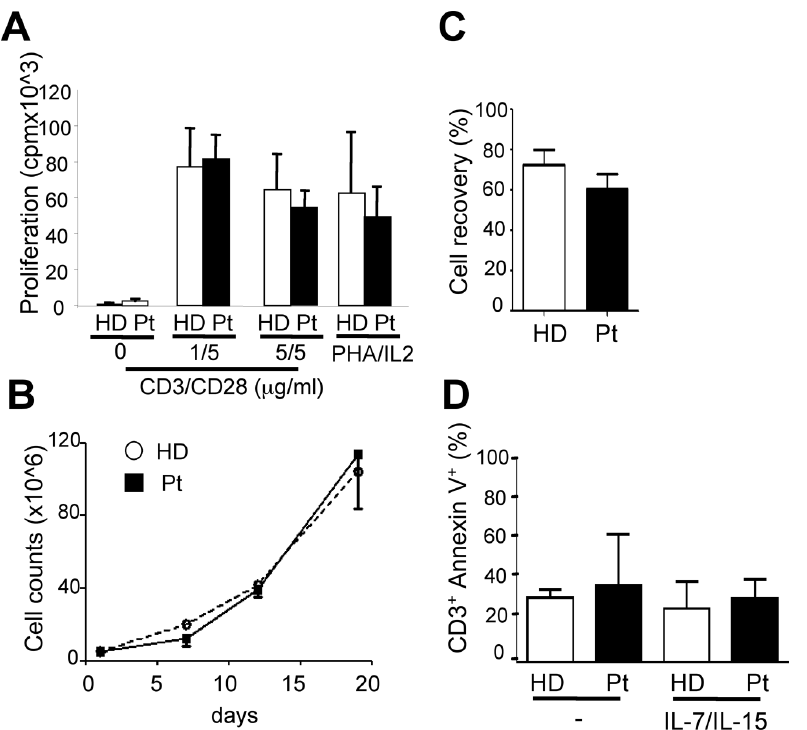
Figure 3. T cells from TSC subjects proliferate and survive to similar extents in response to mitogenic signals. A) Freshly isolated PBMC of four healthy donors (HD, white bars) and four TSC subjects (Pt, black bars) were left unstimulated (0) or activated on plate-coated anti-CD3 and anti-CD28 mAb or PHA and IL-2 for 4 days. Proliferation was assessed by a 18 h- 3 H-thymidine incorporation assay. Data depict mean 3 H-thymidine incorporation 6 SEM. B) freshly isolated PBMC (1 HD, 2 TSC1 Pts) were activated on anti-CD3/CD28 coated beads for 6 days. Thereafter, T cells were isolated and maintained in culture with IL-7 and IL-15 (see methods). At the indicated times, viable counts were obtained. Data are depicted as fold expansion over input and represent one out of two independent determinations. C) Freshly isolated frozen PBMC were thawed and cultured overnight in complete medium. Viable cells were counted. Data are expressed as percentage of input and represent the mean of 10 HD and 4 TSC1 Pts ( 6 SEM) analyzed in independent experiments. D) Frozen CD3 + cell lines obtained from 2 HD and 3 TSC1 Pts were thawed, and cultured (2 6 10 ‘ 6/ ml) in the absence (-) or presence of IL-7 and IL-15 (5 ng/ml). After 24 h cells were analyzed by flow cytometry. CD3 + , Annexin V + cells are depicted. (Figure 5C), and the presence of a higher fraction of Annexin V + cells within shTSC1 cultures (Figure 5D). Accordingly, while control and scrambled shRNA infected cells persisted over time in culture, shTSC1 failed to survive (Figure 5E). The use of a second shRNA able to downregulate TSC1 (shTSC1a; Figure 5F) similarly impaired T cell survival (Figure 5E). Thus, TSC1 down-regulation hinders proper mTORC2 control, and favors death of primary human T cells.